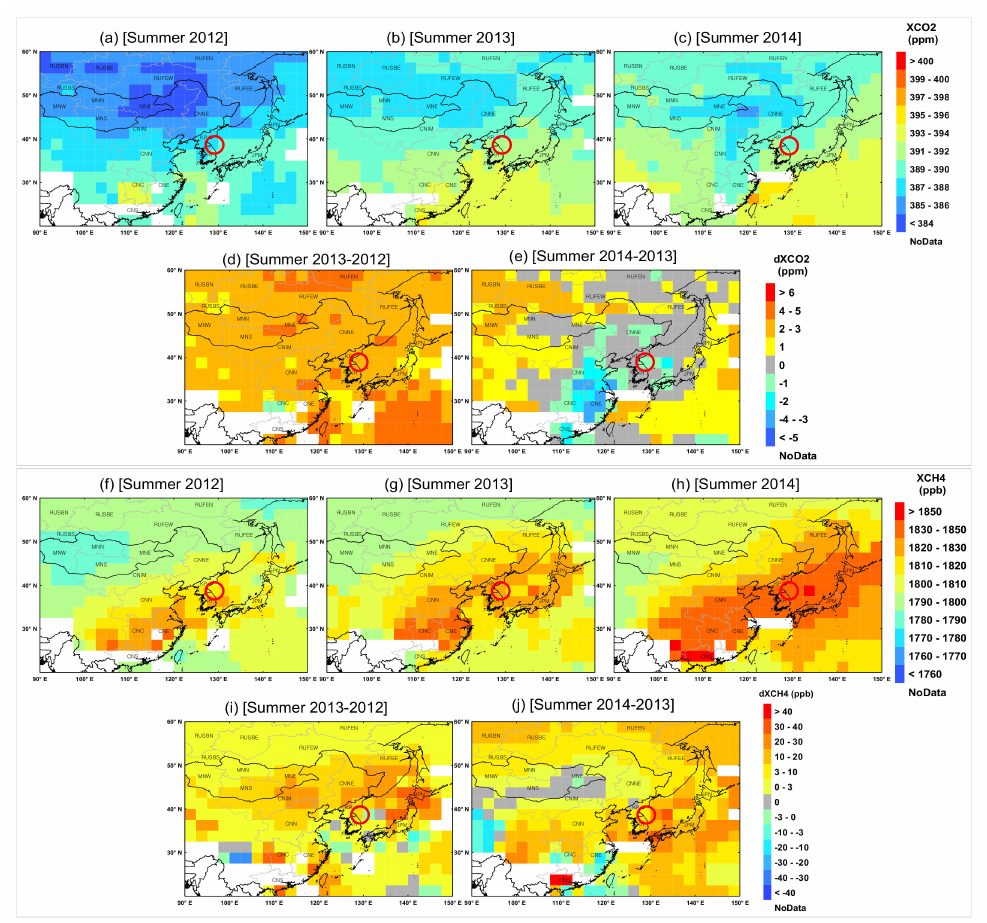
Figure 5. Spatial distributions of the mean summer XCO 2 ( a – c ) every year and increments of mean XCO 2 this summer from previous summer ( d , e ). Spatial distributions of the mean summer XCH 4 ( f – h ) every year and increments of mean XCH 4 this summer from previous summer ( i , j